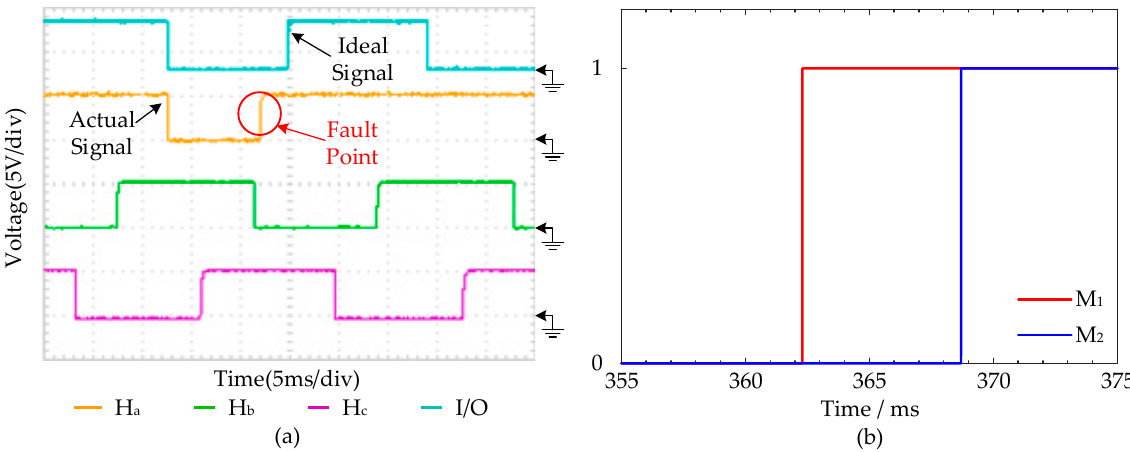
Figure 14. Hall Fault Type 2 diagnosis experimental results: ( a ) The Hall signal curves at Fault Type 2 and the ideal Hall signal curves. ( b ) The fault diagnosis experimental curves of M 1 and M 2 .